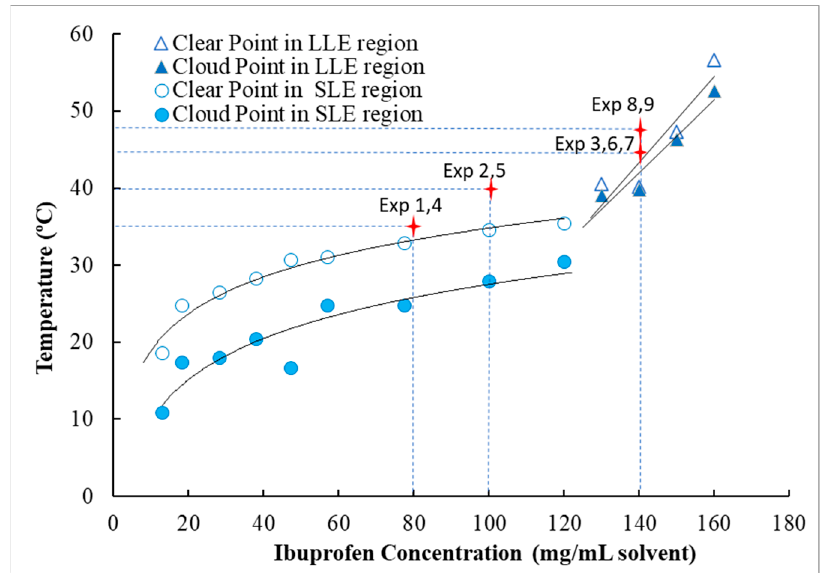
Figure 3. Kinetic phase diagram of ibuprofen in ethanol/water mixtures (50/50, v / v ). The positions of the starting solution are labelled as bold crosses.